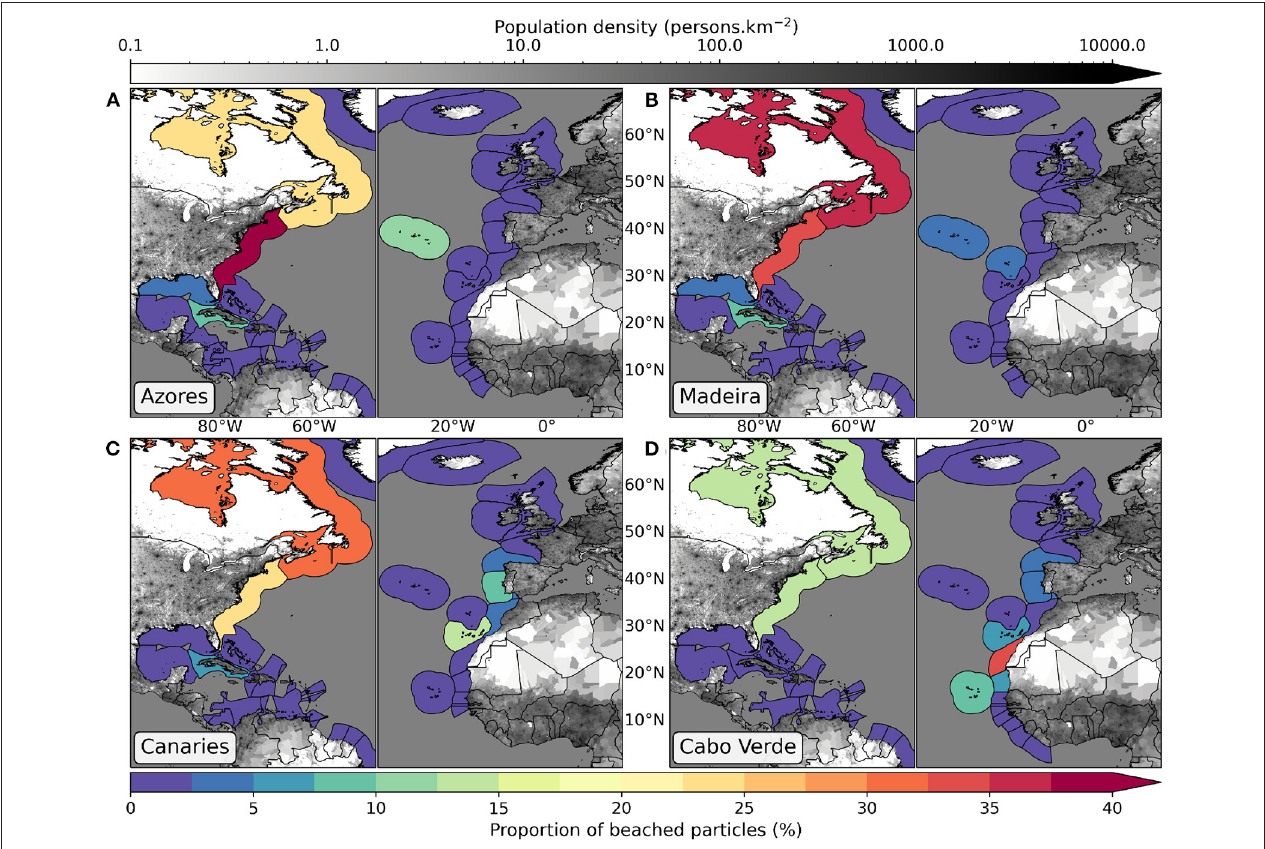
FIGURE 8 | Proportion of B surface particles released in the Azores (A) , Madeira (B) , Canaries (C) , and Cabo Verde (D) and beached per country coastline. Countries with coastlines in different seas are divided accordingly (e.g., Atlantic and Mediterranean Spain). On land, gray colors map represents population density.